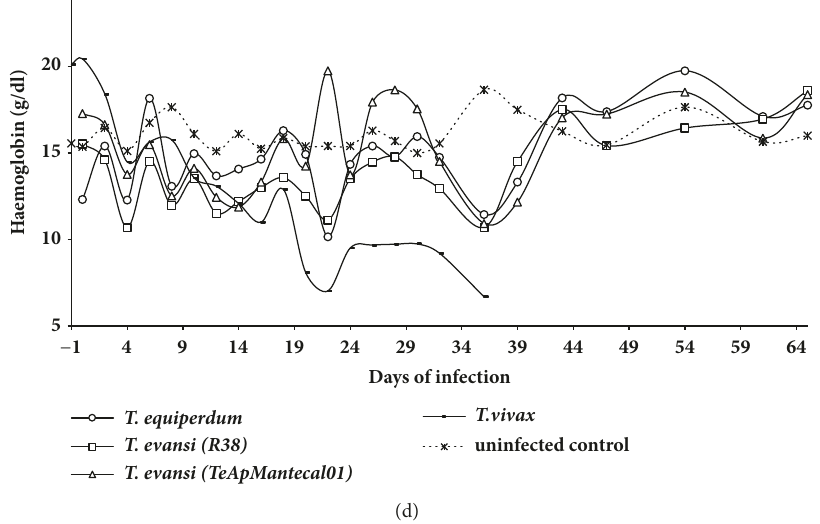
Figure2: ClinicalchangesinexperimentalsheepinfectionbyTrypanosomaevansi(TeApMantecal01andR38),Trypanosomaequiperdum(TeAp- N/D1), and Trypanosoma vivax (Tucacas) isolates. Sheep were inoculated intravenously via jugular vein with 1 x 10 6 parasites obtained from infected rats. The course of the infection was monitored for 65 days without treatment for T. evansi and T. equiperdum infections. The T. viv ax inoculated sheep were treated (Trypamidium (cid:2) ) at 36 days postinfection to prevent animal death and safeguard its health. The clinical parameters monitored interdaily were as follows: (a) rectal temperature was determined using a column thermometer and expressed in ∘ C. (b) Changes in hematocrit values: PCV was estimated using microhematocrit tubes every 2 days and expressed as the average percent. (c) Red cell count was determined by direct counting from blood using a Neubauerchamber and expressed in cell/ml of blood. (d) Haemoglobin concentration was determined by cyanmethemoglobin method and expressed in